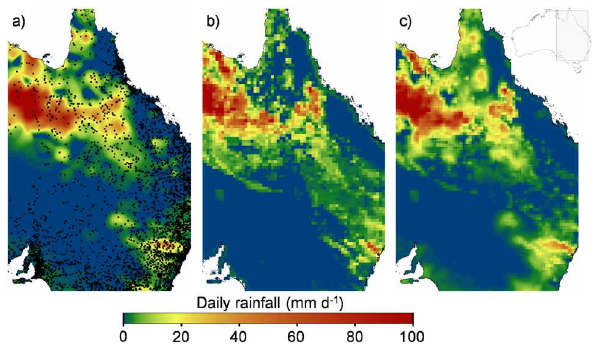
Fig. 4. Daily rainfall estimates for 5 January 2005: (a) gauge-only analysis (Jones et al., 2009) (black dots represent gauge locations); (b) 24-h accumulations of satellite-based TMPA 3B42 rain rates; and (c) blended satellite-gauge rainfall estimate generate using the kernel-based algorithm of Li and Shao